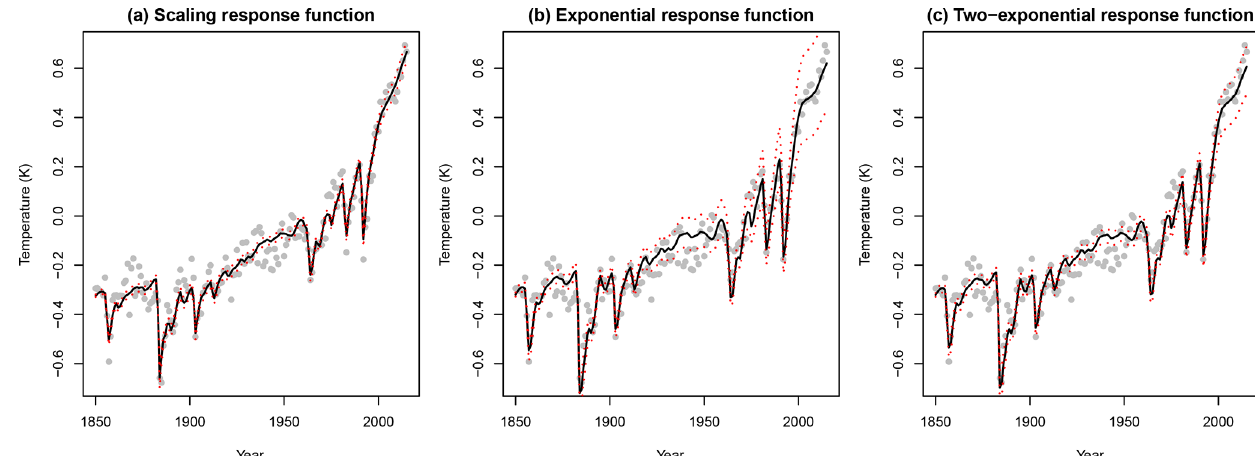
Figure 2. The marginal posterior mean and 95% credible intervals of the temperature response to known forcing µ obtained by 100000 Monte Carlo simulations compared to GISS-E2-R temperature data. Panel (a) shows the results under the scale-invariant assumption, panel (b) shows the results using a single-exponential response, and panel (c) shows the results using a mixture of two-exponential response